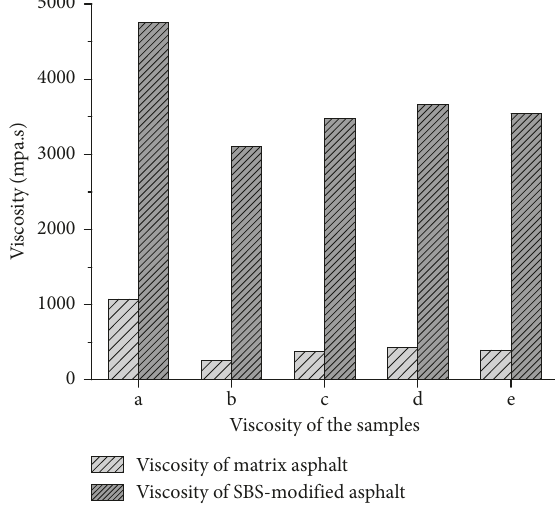
Figure 4: Viscosity of the